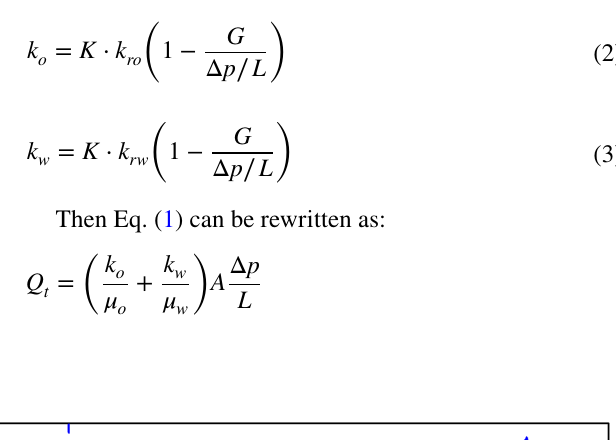
Fig. 4 Relation between oil recovery percent difference and oil saturation